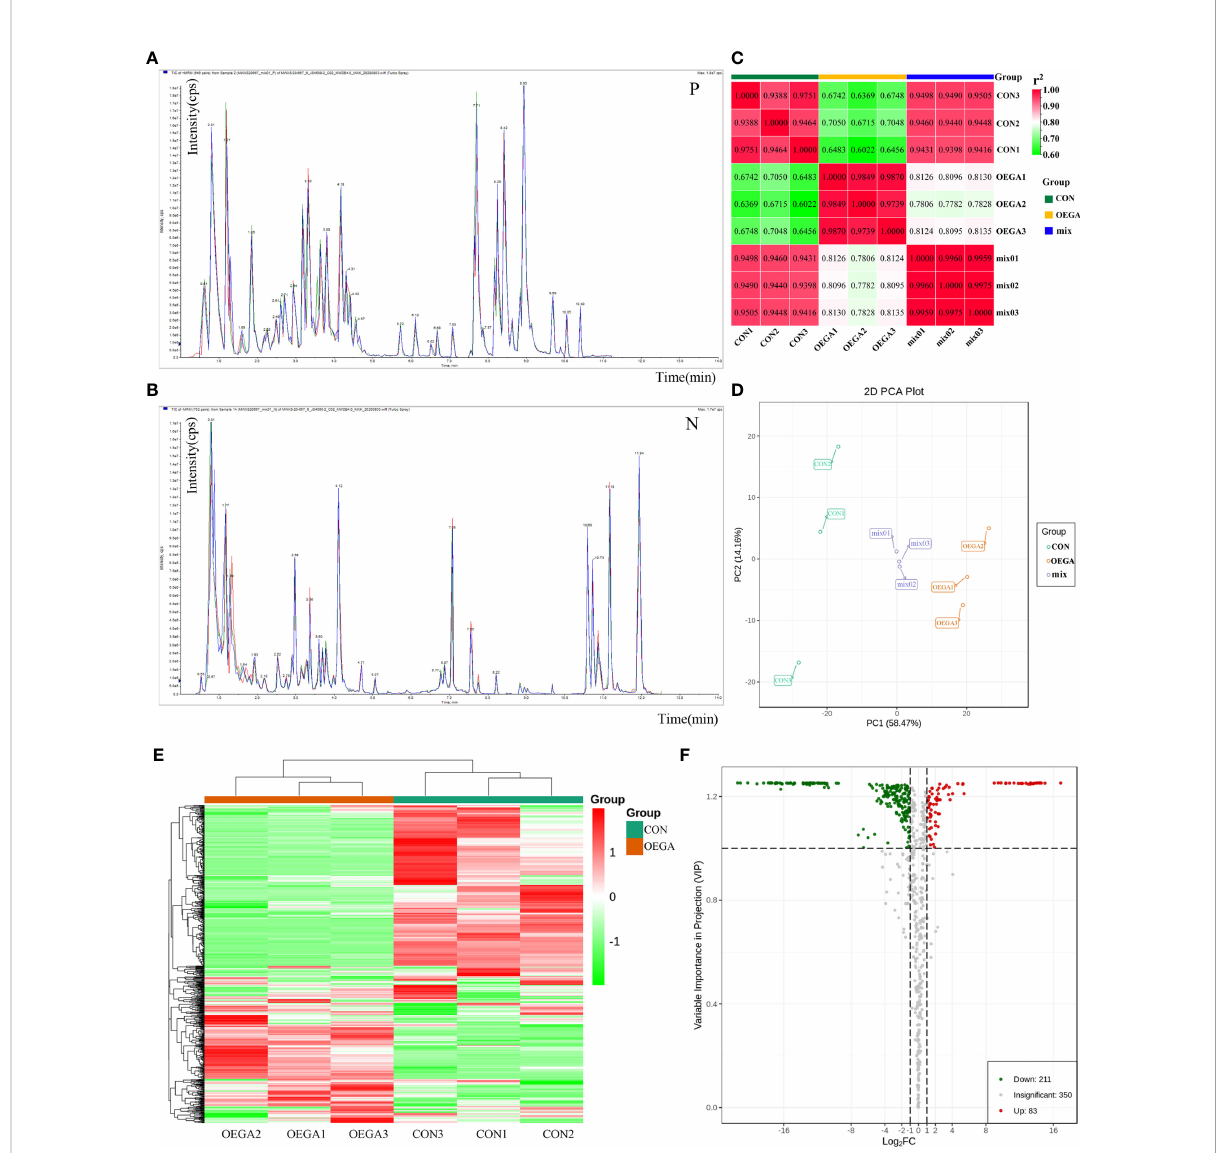
FIGURE 4 Metabolomics pro fi les of the citrus leaves from the OEGA and CON samples. (A) and (B) Overlapping analysis of the total ion current in the different quality control (QC) samples. The abscissa indicates the retention time (RT) of the metabolites, and the ordinate indicates the ion current intensity in counts per second (cps). The three different colors represent the three QC samples. N represents the negative ion mode, and P represents the positive ion mode. (C) Pearson ’ s correlation coef fi cients among the citrus samples CON, OEGA, and mix (QC). The abscissa and ordinate indicate corresponding sample names. The color represents the correlation coef fi cient (r 2 ). (D) Principal component analysis of all the metabolites. OEGA: yellow; CON: green; mixed: purple. The abscissa represents the fi rst principal component (PC1), and the ordinate represents the second principal component (PC2). The percentage indicates the interpretation rate of the principal components in the dataset. (E) Cluster heatmap of the differences in the metabolite content between the OEGA and CON groups. The sample name is indicated on the abscissa, and the metabolite information is shown on the ordinate. The cluster line on the left of the Figure is the metabolite cluster line, and that on the top of the Figure represents the sample cluster line. The different colors represent the values obtained after the relative content standardization process (red represents high content, and green represents low content). (F) Volcano plot of the differential metabolites. Green dots represent downregulated metabolites, red spots represent upregulated metabolites, and gray dots represent metabolites with insigni fi cant